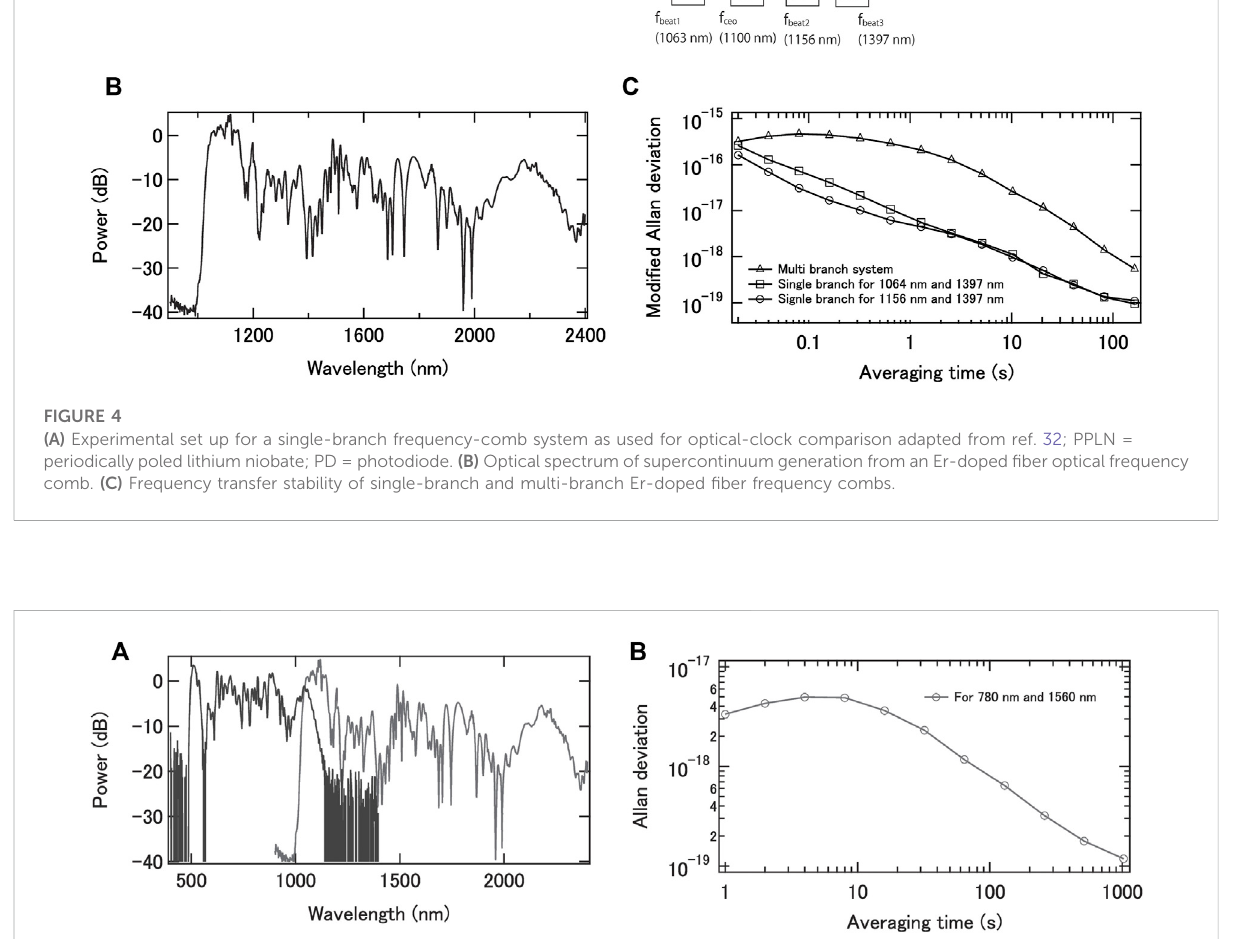
ampli fi er, a highly coherent supercontinuum spanning the whole range from around 500 nm to 2,400 nm can be generated, where a frequency stability better than 10 − 18 in 1 s is potentially achievable [34]. The coherently stitched spectrum and the measured frequency stability between 1,560 and 780 nm are shown in Figures 5A,B respectively.